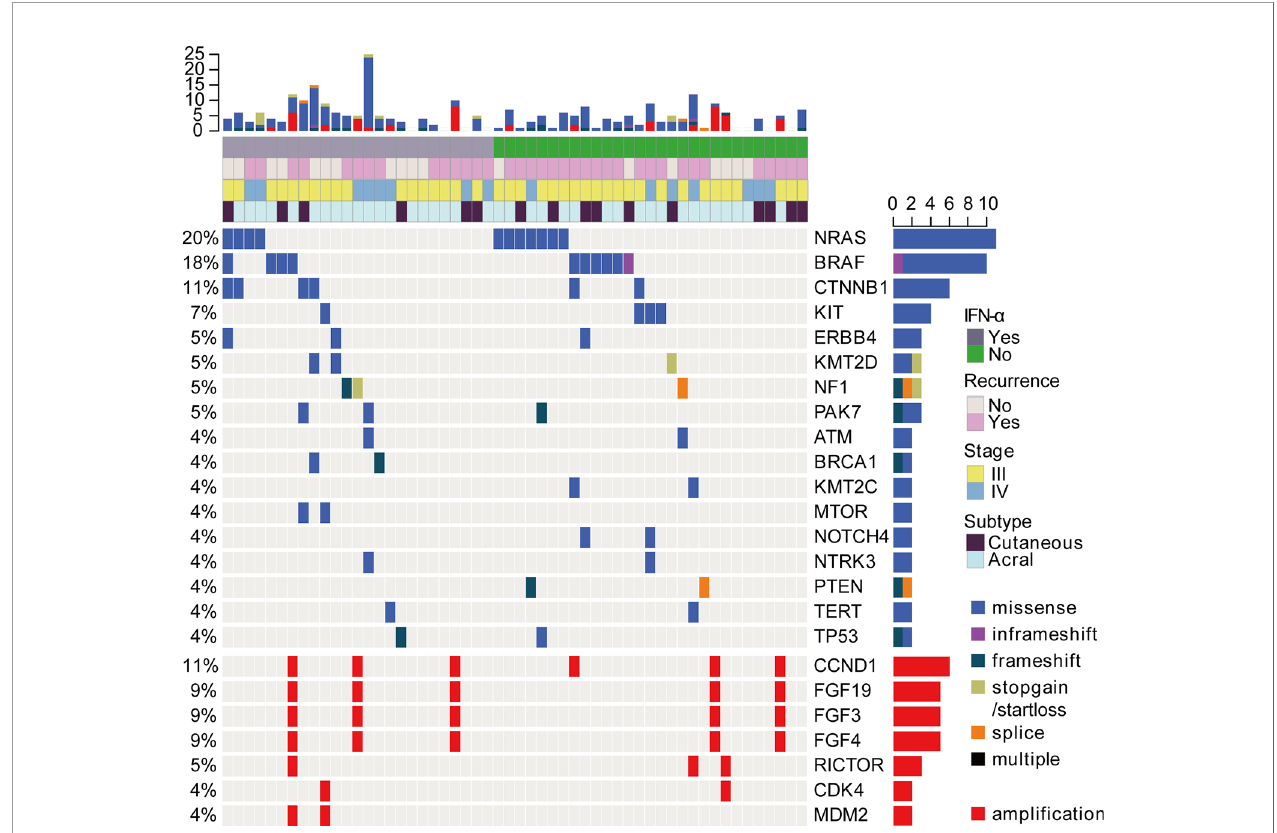
FIGURE 2 | The landscape of driver mutations and CNVs in acral (n = 40) and cutaneous (n = 16) melanomas by targeted NGS. Each column represents a case and each row represents a gene. The very top bar graph shows the number of mutations and CNVs detected in each sample. Recurrence after adjuvant pembrolizumab treatment, prior treatment, stage, and subtype are represented in the rows. The number on the left indicates the percentage of mutations or CNVs in 56 samples. The bar graph on the right shows the total number of mutations or CNVs for each gene. Mutation pro fi ling was shown in the top panel. Copy number analysis was also analyzed and shown in the bottom